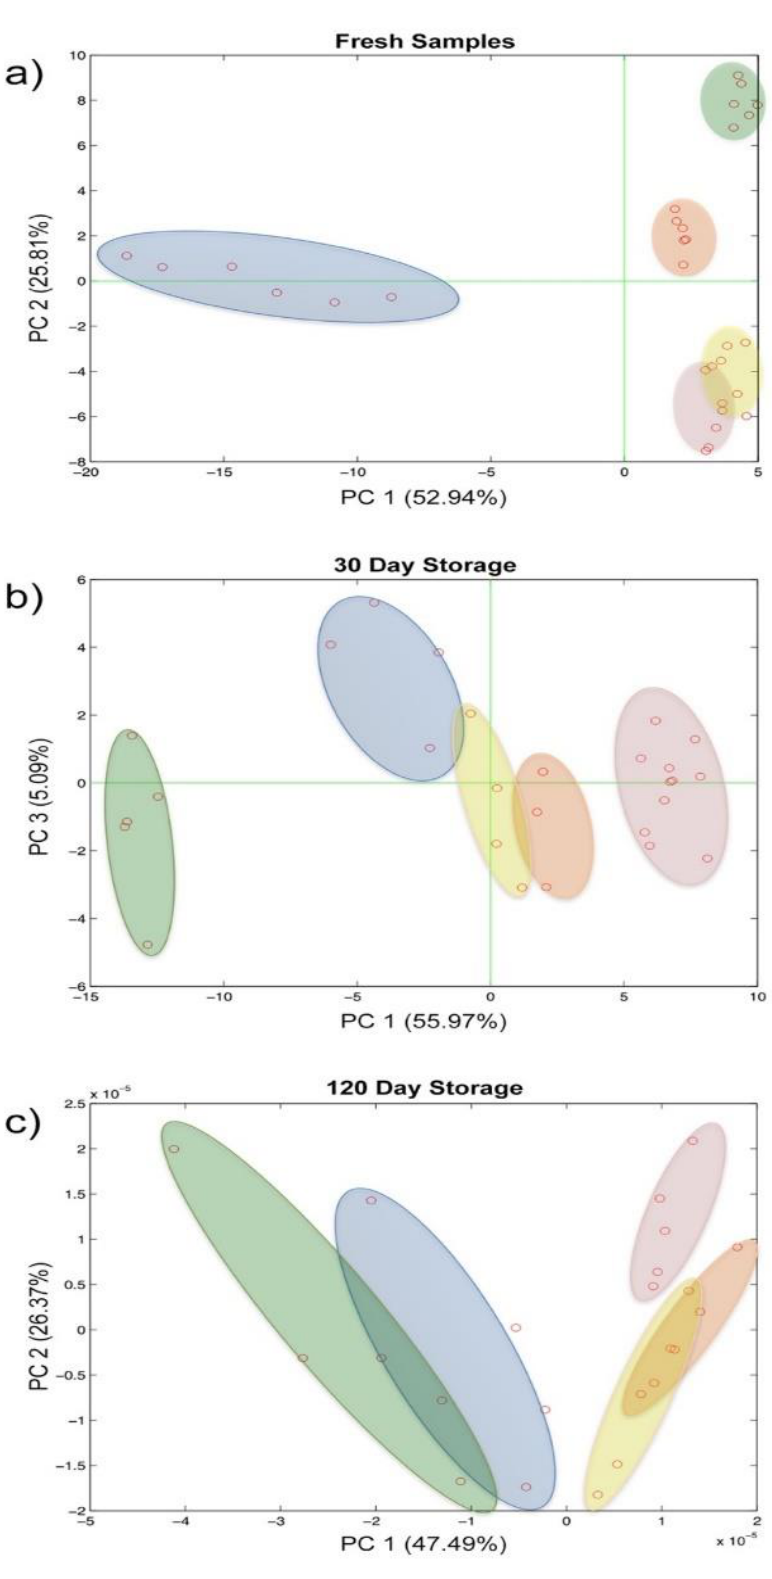
Figure 6. Score plot of the principal component analysis on repeatability and reproducibility evaluation: ( a ) fresh samples, ( b ) 30 days storage, ( c ) 120 days storage.